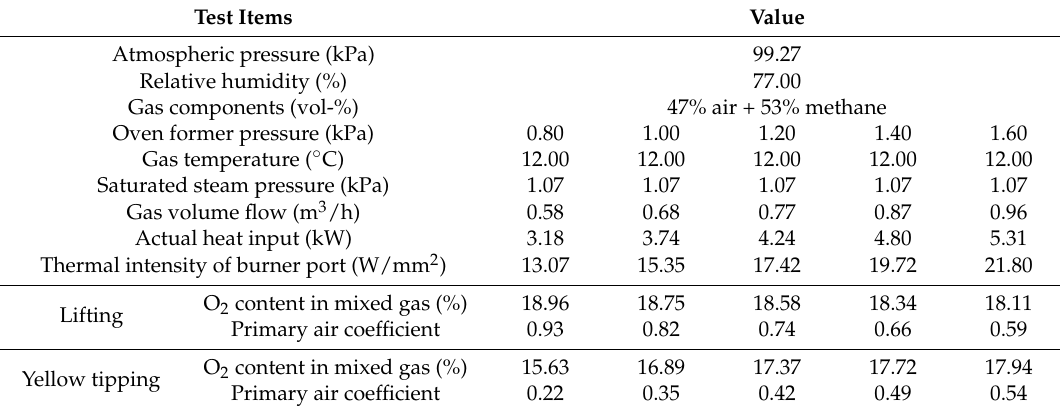
Table 5. Flame stability testing data of the substitute